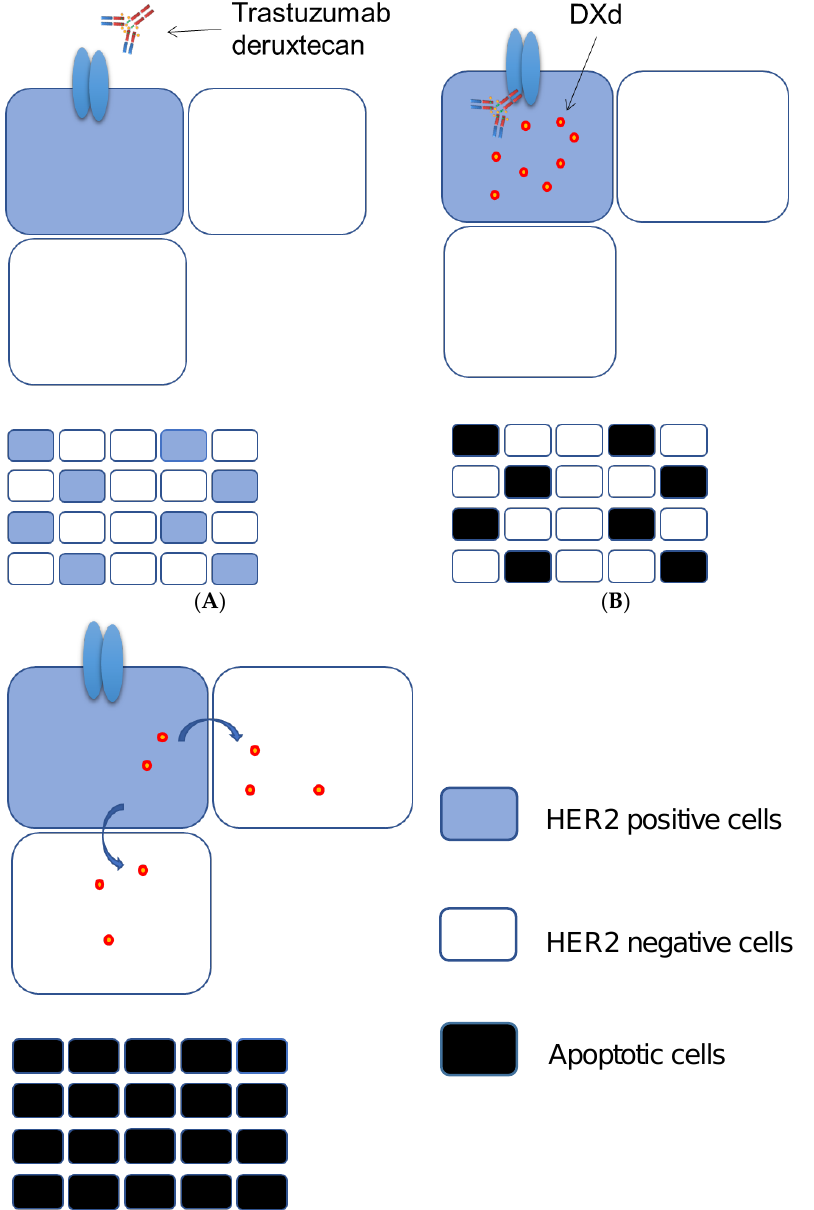
Figure 1. Proposed mechanism for the “bystander killing effect” of trastuzumab deruxtecan. The binding of trastuzumab deruxtecan to HER2 expressed on the surface of HER2-positive tumor cells ( A ) triggers its internalization followed by the release of DXd into the cytoplasm and the induction of apoptosis ( B ). ( C ) DXd is then transferred to and induces apoptosis in neighboring HER2-negative cells.